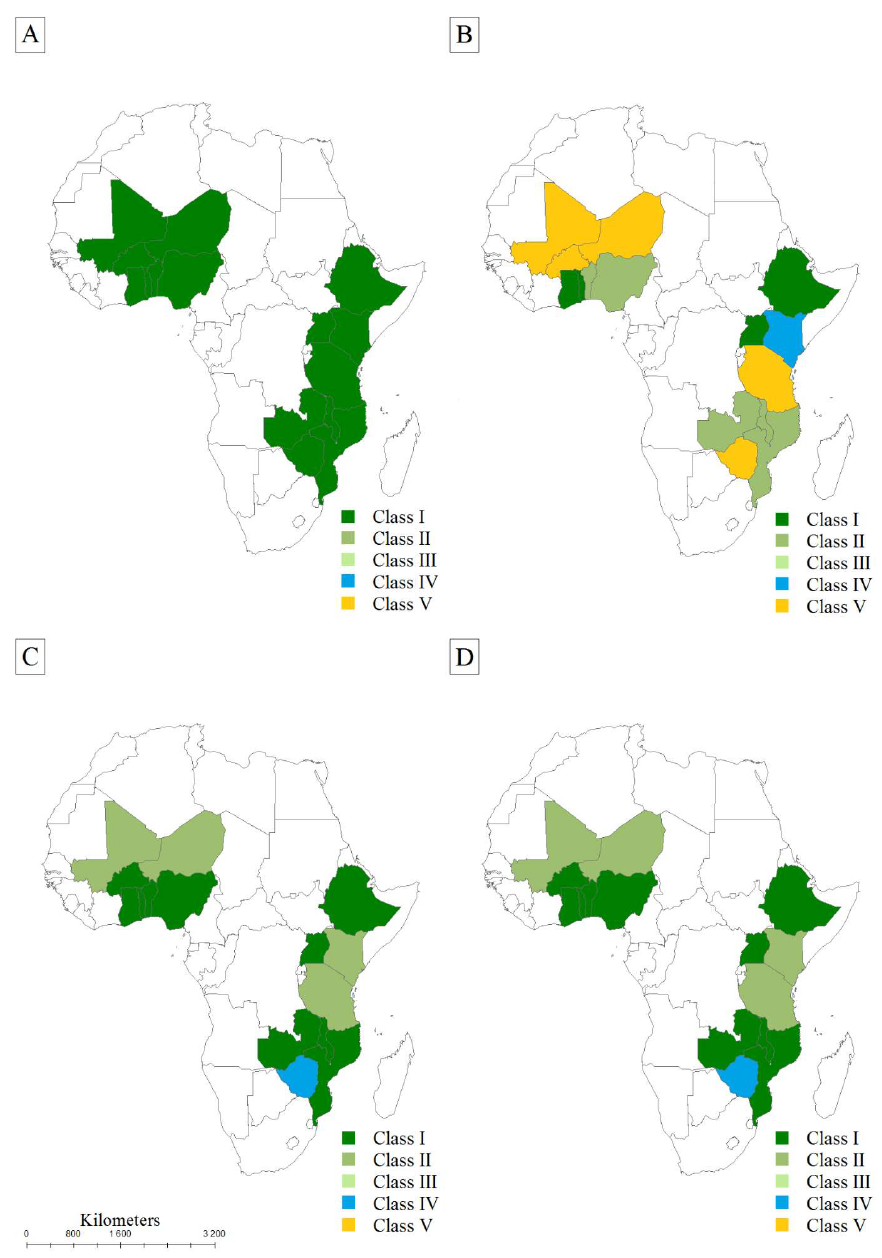
Figure 4. Allocation of the 15 selected countries to classes based on different scenarios. ( A ) Current situation; ( B ) Scenario 1; ( C ) Scenario 2; and ( D ) Scenario 3. For an explanation of classes I–VI, see Table